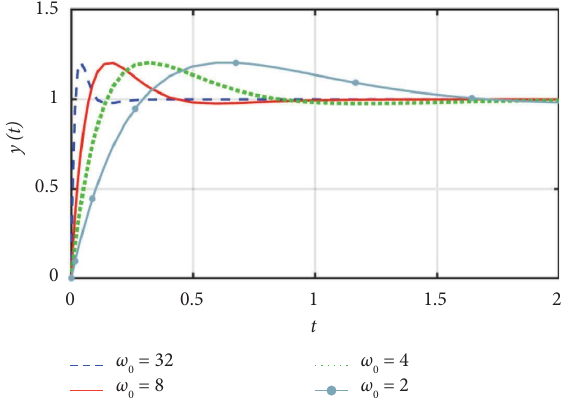
corresponding to the step signal 1